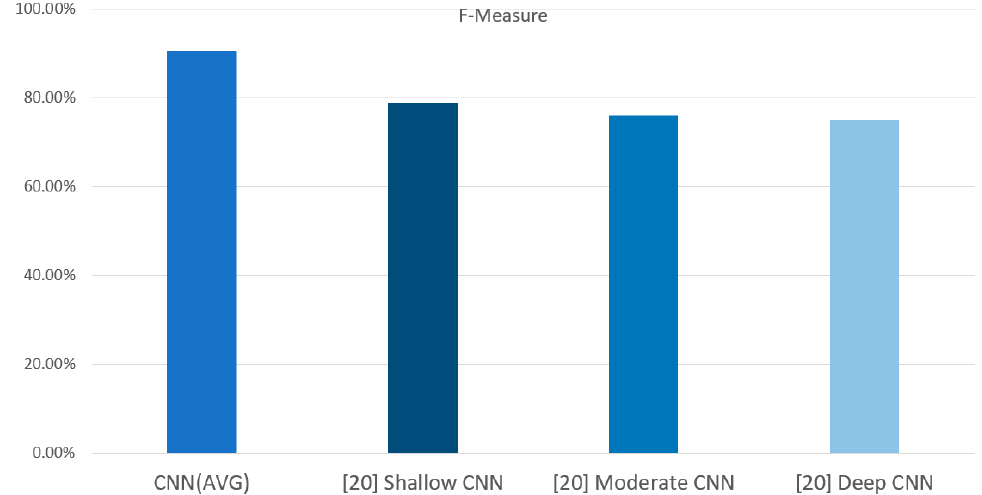
Figure 5. Performance comparison with CNN-based studies using F-Measure.